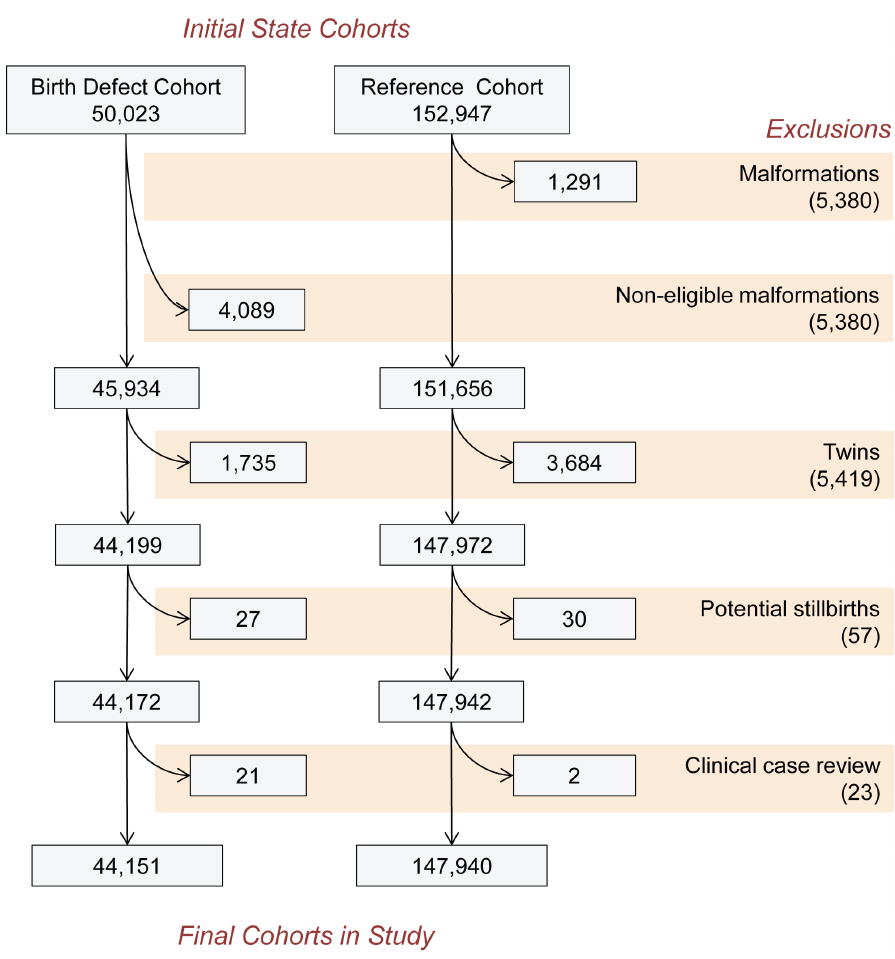
Figure 1. Inclusions and exclusions leading to final cohorts in the UTAZIA study of birth defects and cancer.